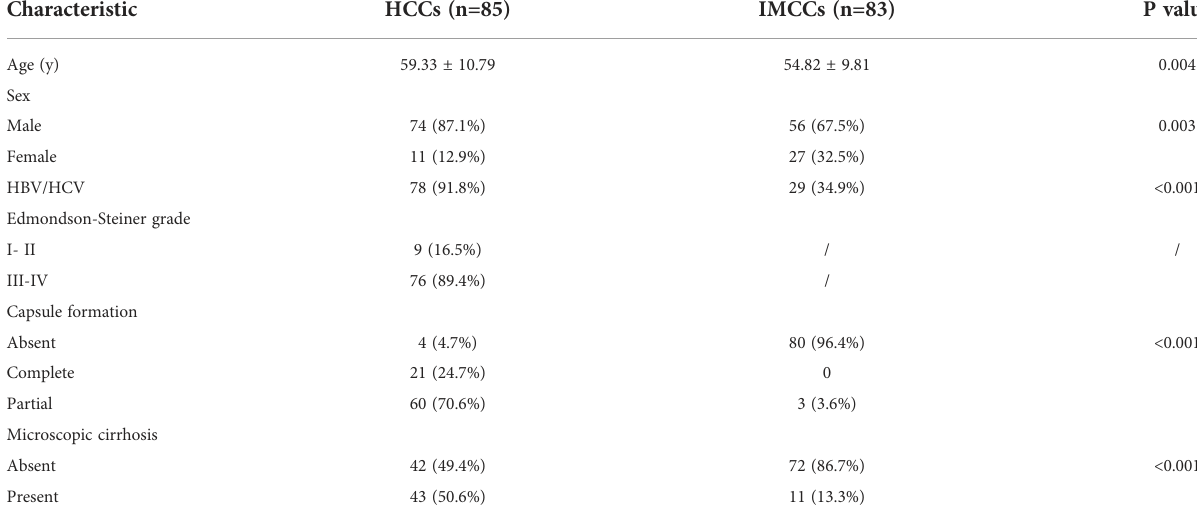
TABLE 1 Demographic and pathological characteristics of HCCs and